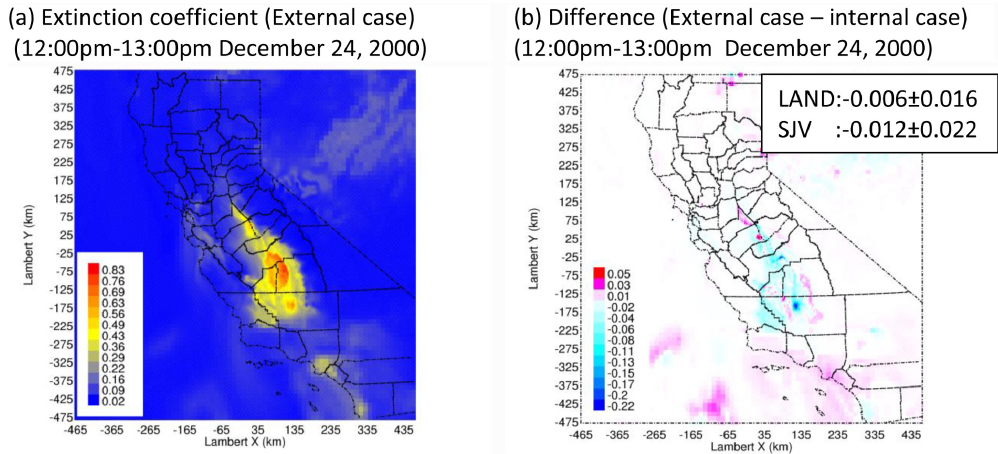
Fig. 5. Hourly extinction coefficient averaged from 12:00 to 13:00LT on 24 December 2000 calculated by (a) the external case and (b) difference between external case and internal case in units of km − 1 . Note that the maximum value for each panel is adjusted to best illustrate the spatial patterns. Averaged differences over land and the SJV covered by the 4km domain are shown in the text box.